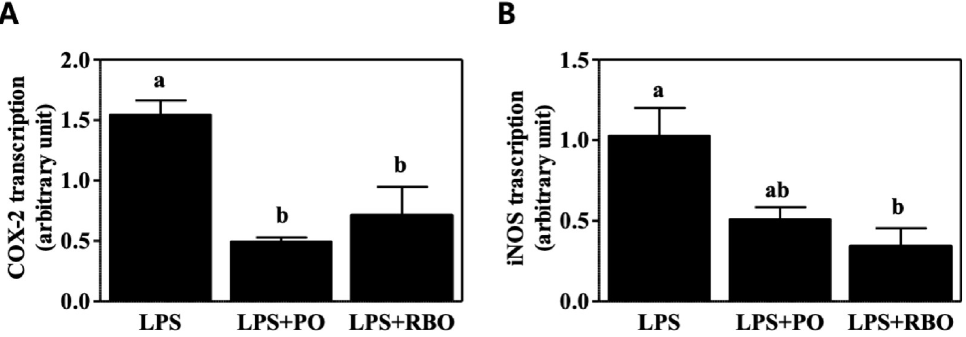
Fig 3. Transcription of COX-2 and iNOS, inflammatory mediator genes, as assessed by qRT-PCR in LPS-stimulated RAW 264.7 macrophages. Data are presented as mean ± SEM (n = 3). Values with different letters are statistically significant at p < 0.05 within the panel. (PO, palm oil; RBO, rice bran oil).